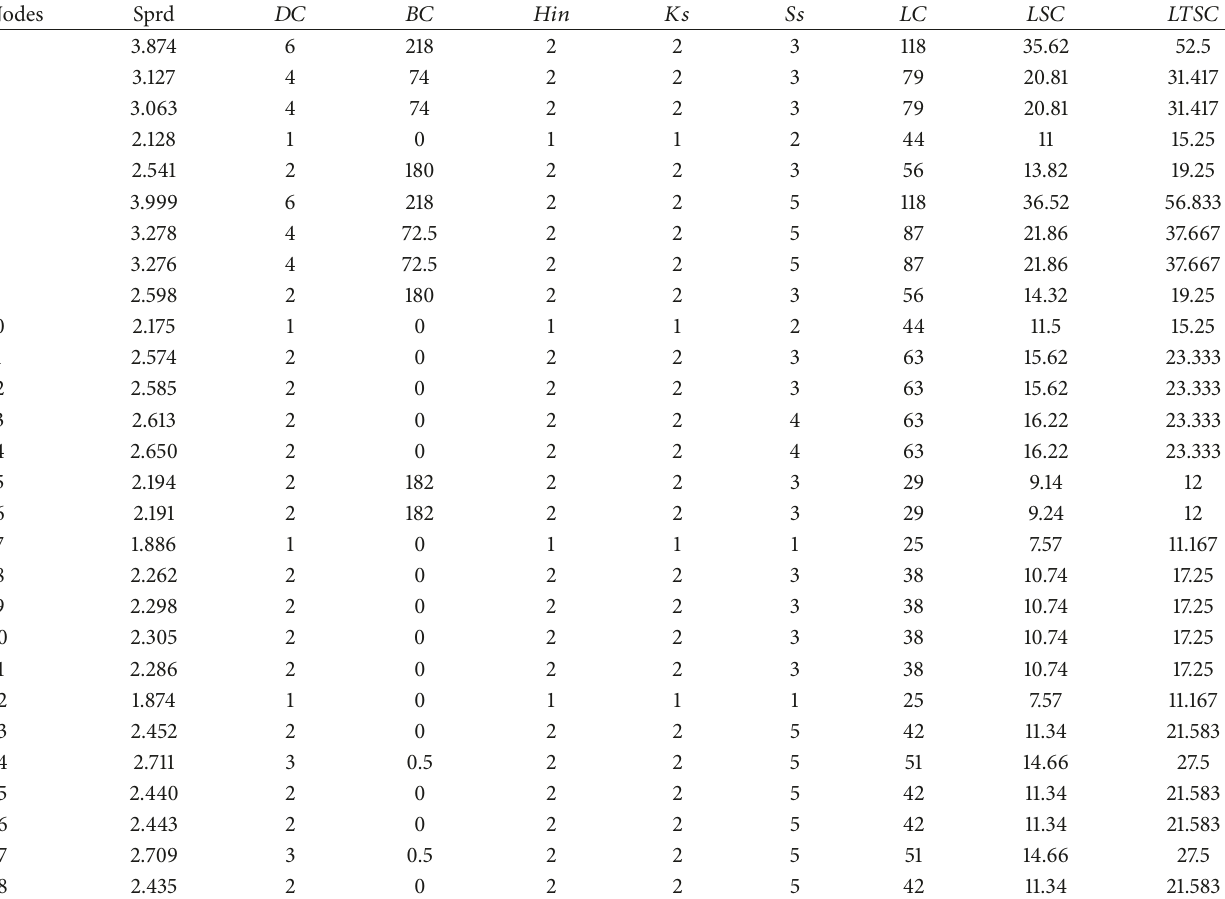
Table 2: The centralities with 8 different measures on the network of Figure 1.